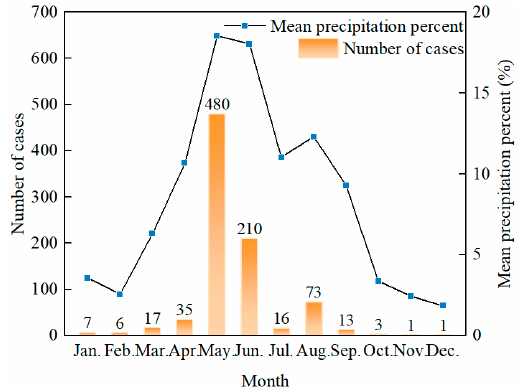
Figure 3. Monthly distribution of shallow landslide events and mean precipitation percentage dur ‐ ing 2010–2020.